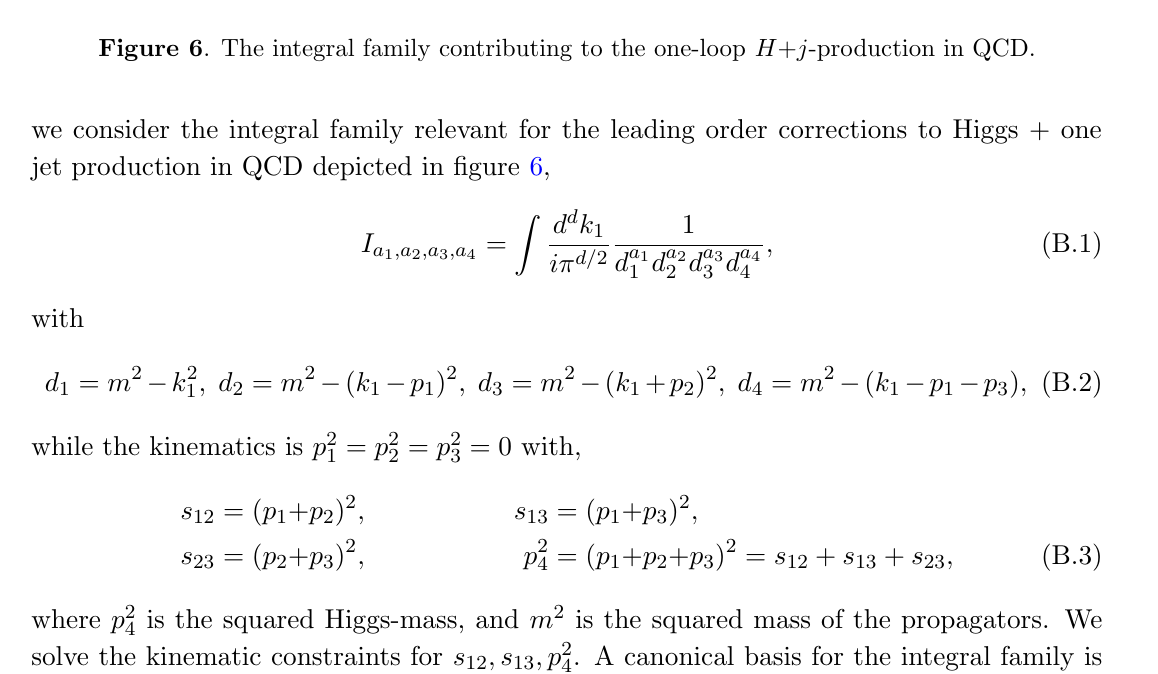
Figure 6 . The integral family contributing to the one-loop H + j -production in